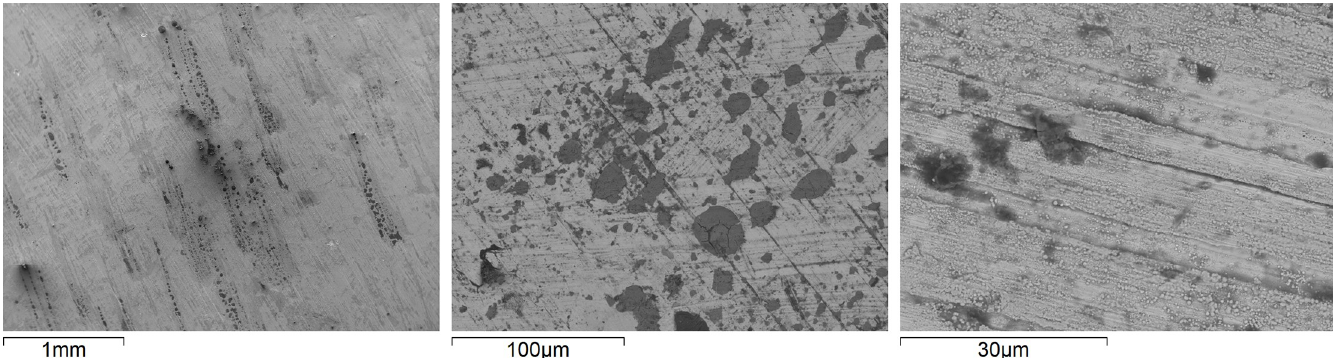
Fig 3. SEM-BE images of locally occurring corrosion features formed on three Cu metal surfaces exposed to daily fingerprint contact (thumb imprint) for one week.